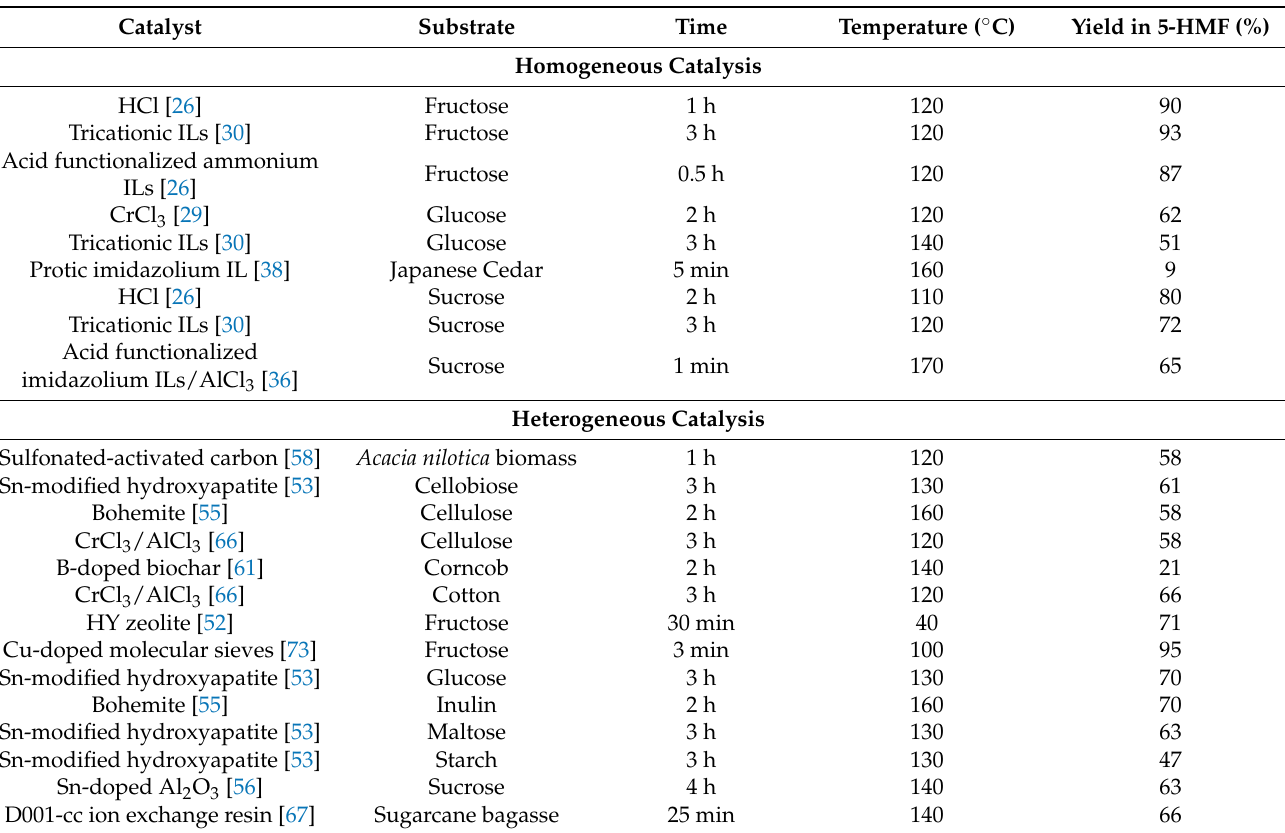
Table 1. Catalysts, reaction conditions, and yields for the selected transformations of carbohydrates and biomass into